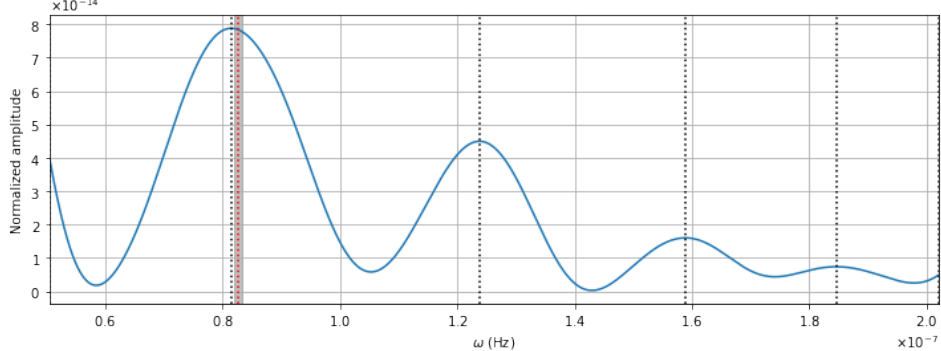
Figure 12. Plot of the LS periodogram of the averaged narrowband post-fit whitened TRs of the MSP J2145–0750, filtered by removing the TRs associated with an uncertainty larger than 3 σ w and the TRs before the sixth year of observation. The black-dotted lines indicate the angular frequencies found by the LS algorithm. The red-dotted line indicates the angular frequency ω = 8.262 + 0.025 − expected for the GWs possibly emitted by the SMBHB candidate PKS 2131–021. The gray shaded area indicates uncertainty on ω at the 3 σ confidence level. The horizontal axis indicates the GW angular frequency, expressed in Hertz. The vertical axis indicates the normalized amplitude, dimensionless.